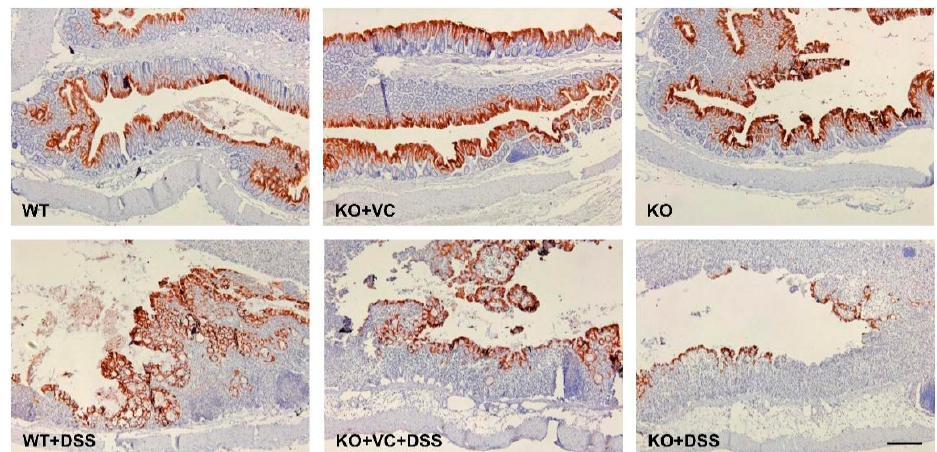
Figure 4. Vitamin C insufficiency and DSS treatment decrease the expression of mucin-1. Mice were treated with DSS for 7 days, and mucin-1 expression was examined by immunohistochemistry. Scale bar, 200 µ m.